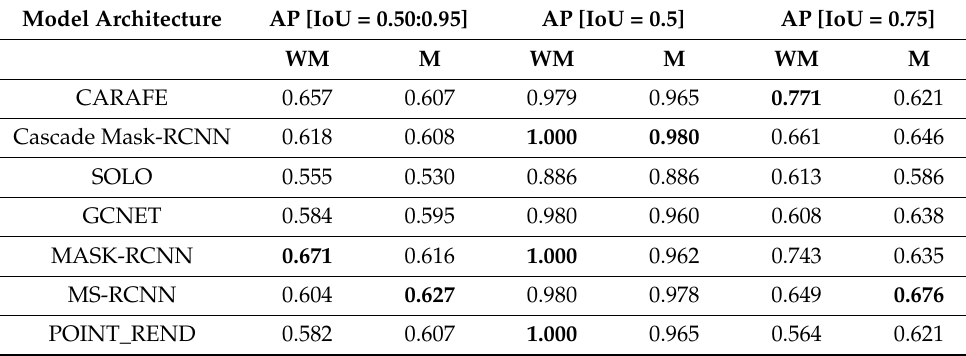
Table 2. Average precision results on reduced Refuge dataset. Model